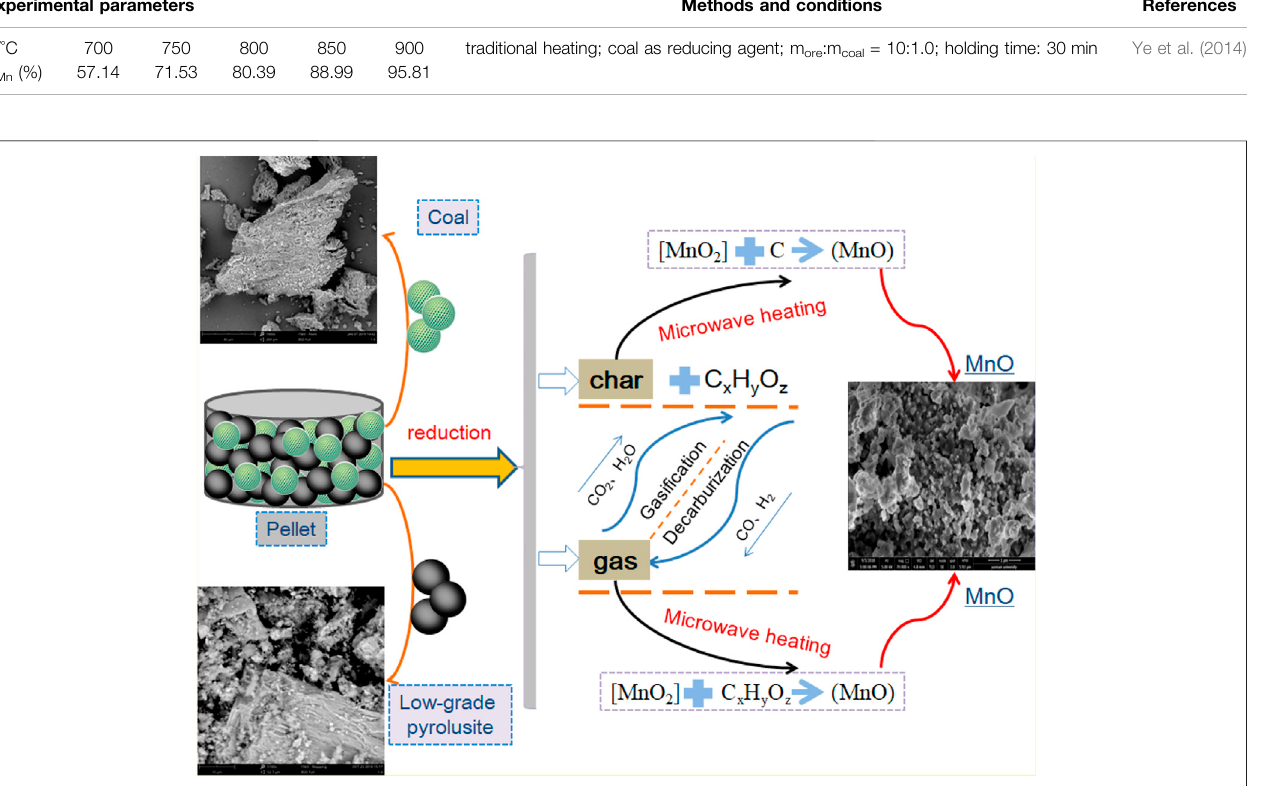
Frontiers in Energy Research |